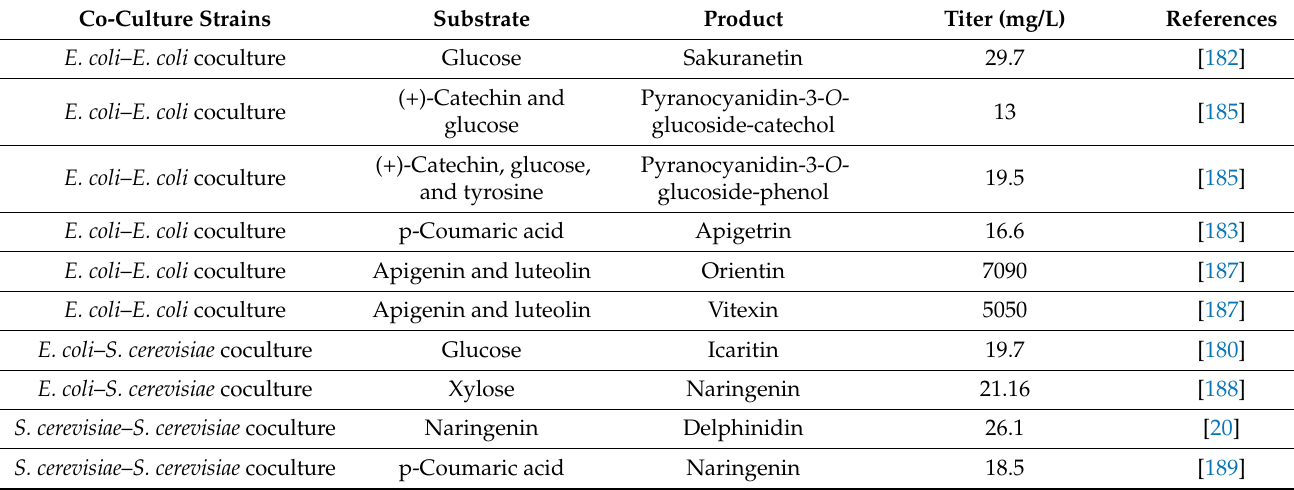
Table 5. Co-culture approach for the microbial production of